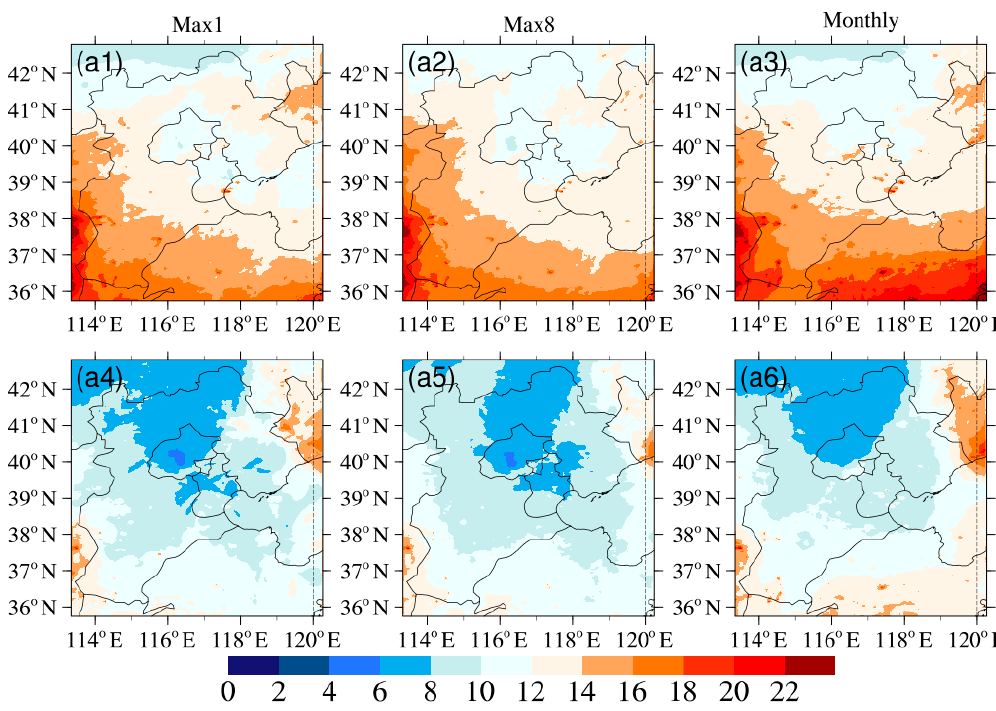
Figure 14. Monthly average relative contribution (%) of BVOCs to ozone formation in July and August 2017 over the NCP ( a1 – a6 ); the left column represents the maximum 1-h average, the middle column represents the maximum 8-h average, the right column represents the monthly average, and the rows from top to bottom represent July and August.